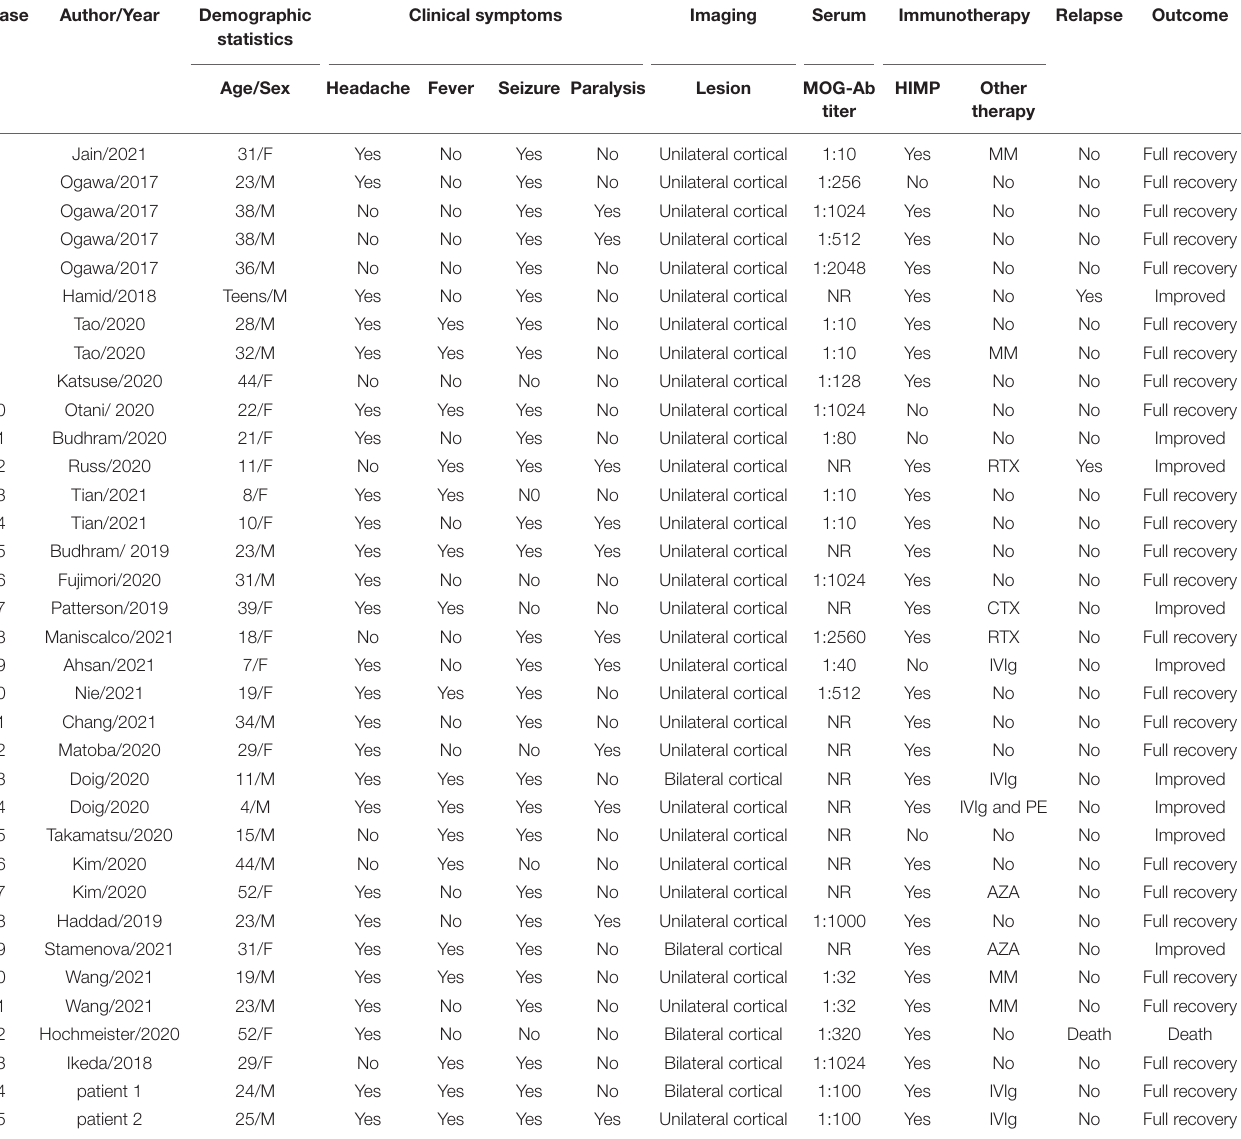
TABLE 1 | Summary of MOG-Ab associated cerebral cortical encephalitis cases included in this